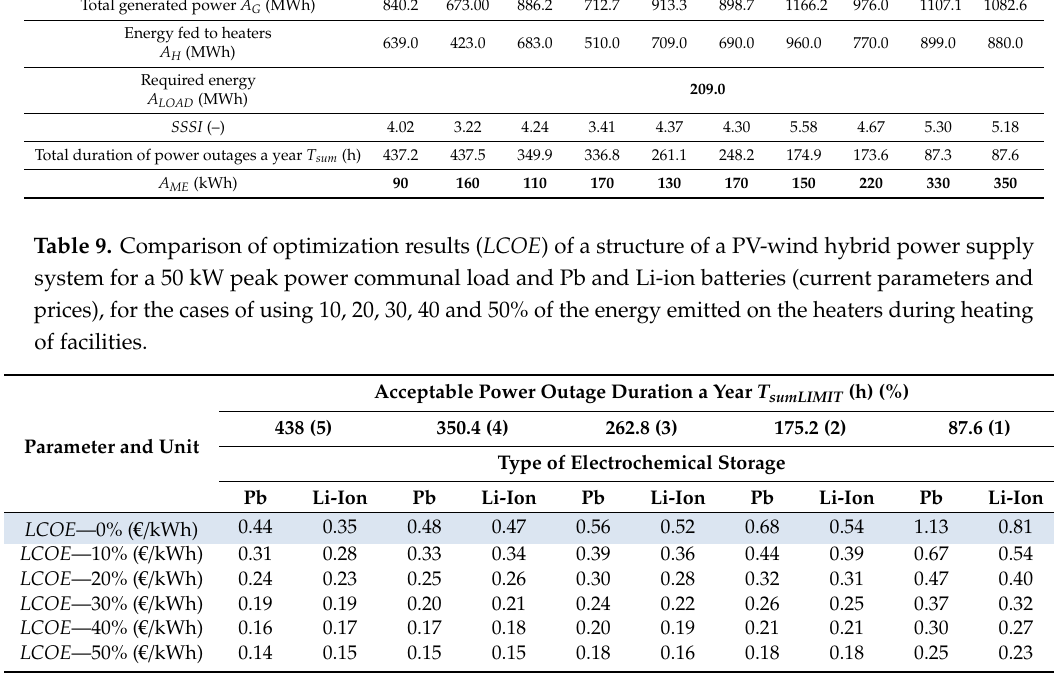
Total duration of power outages a year T sum (h) 437.2